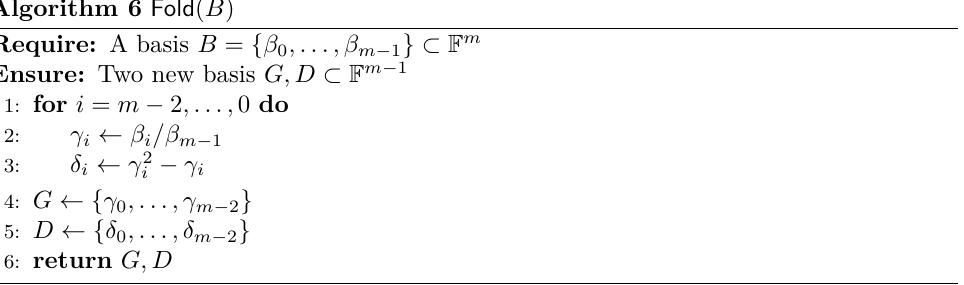
Algorithm 7 GaoMateerFFT ( f, m, B